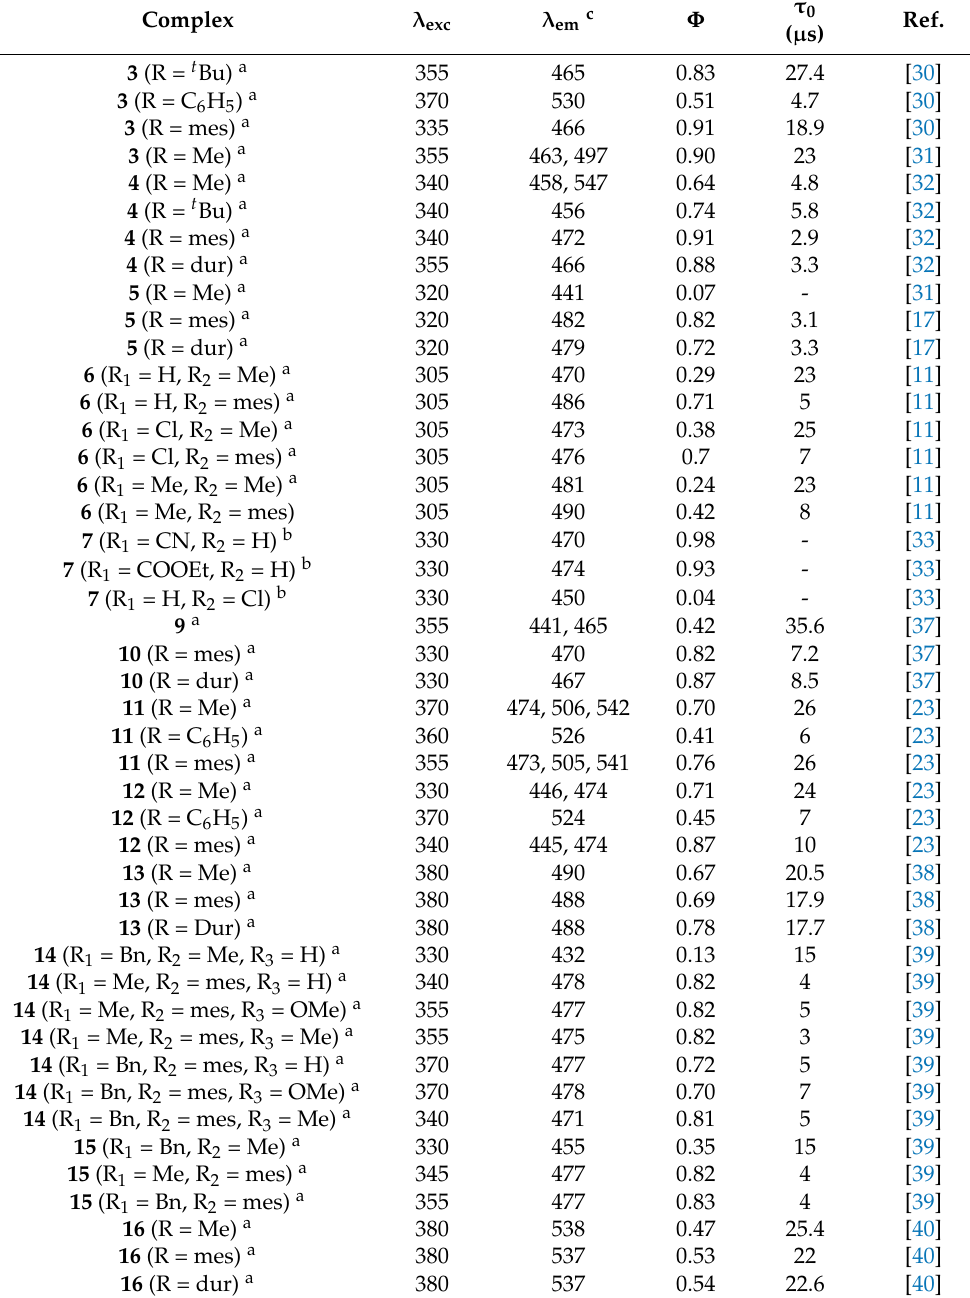
Table 1. Photoluminescence data of some selected complexes (wt% in PMMA) at room